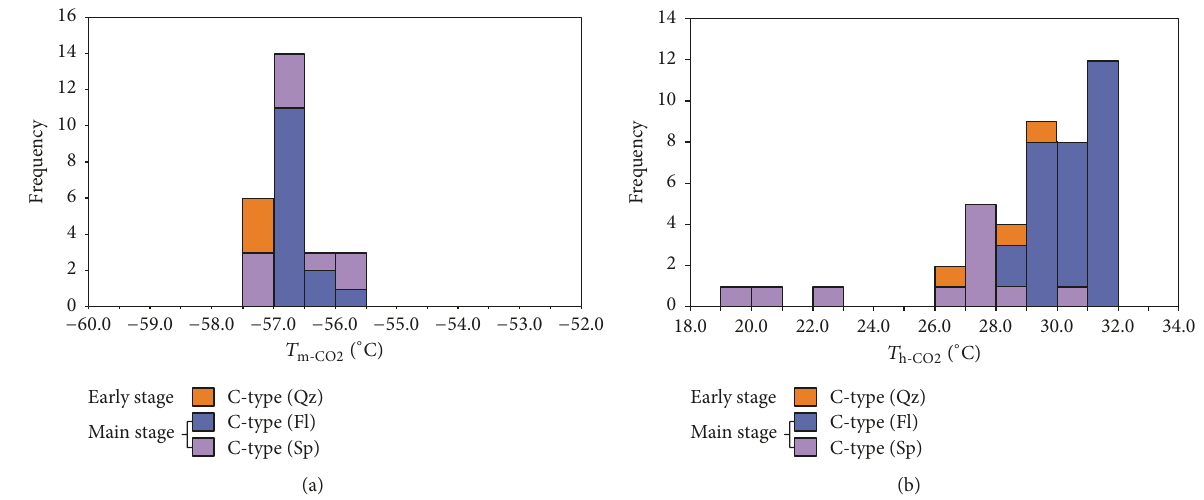
Figure 9: Histograms of CO 2 melting temperature ( 𝑇 m (C-type) inclusions from different types of minerals in the early and main stages. Qz, quartz; Rds, rhodochrosite; Sp, sphalerite; Fl, fluorite.